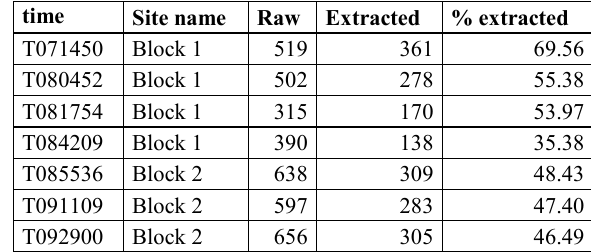
Figure 2. The two areas investigated in this study in Israel.